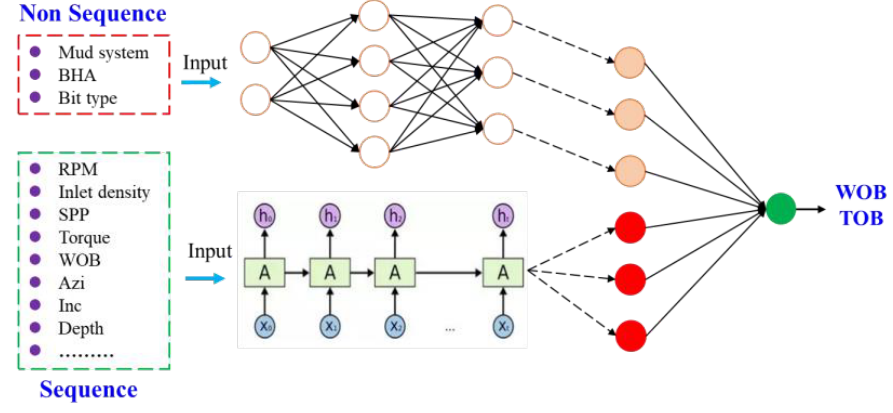
Figure 1. BP-LSTM dual input network structure.